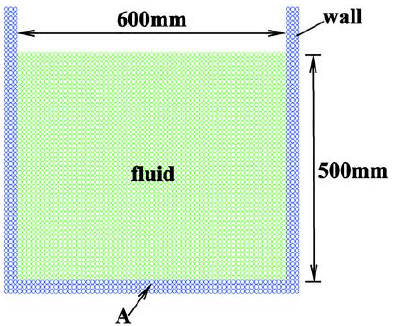
Figure 6. Simulation domain of the hydrostatic calculation in a regular tank.